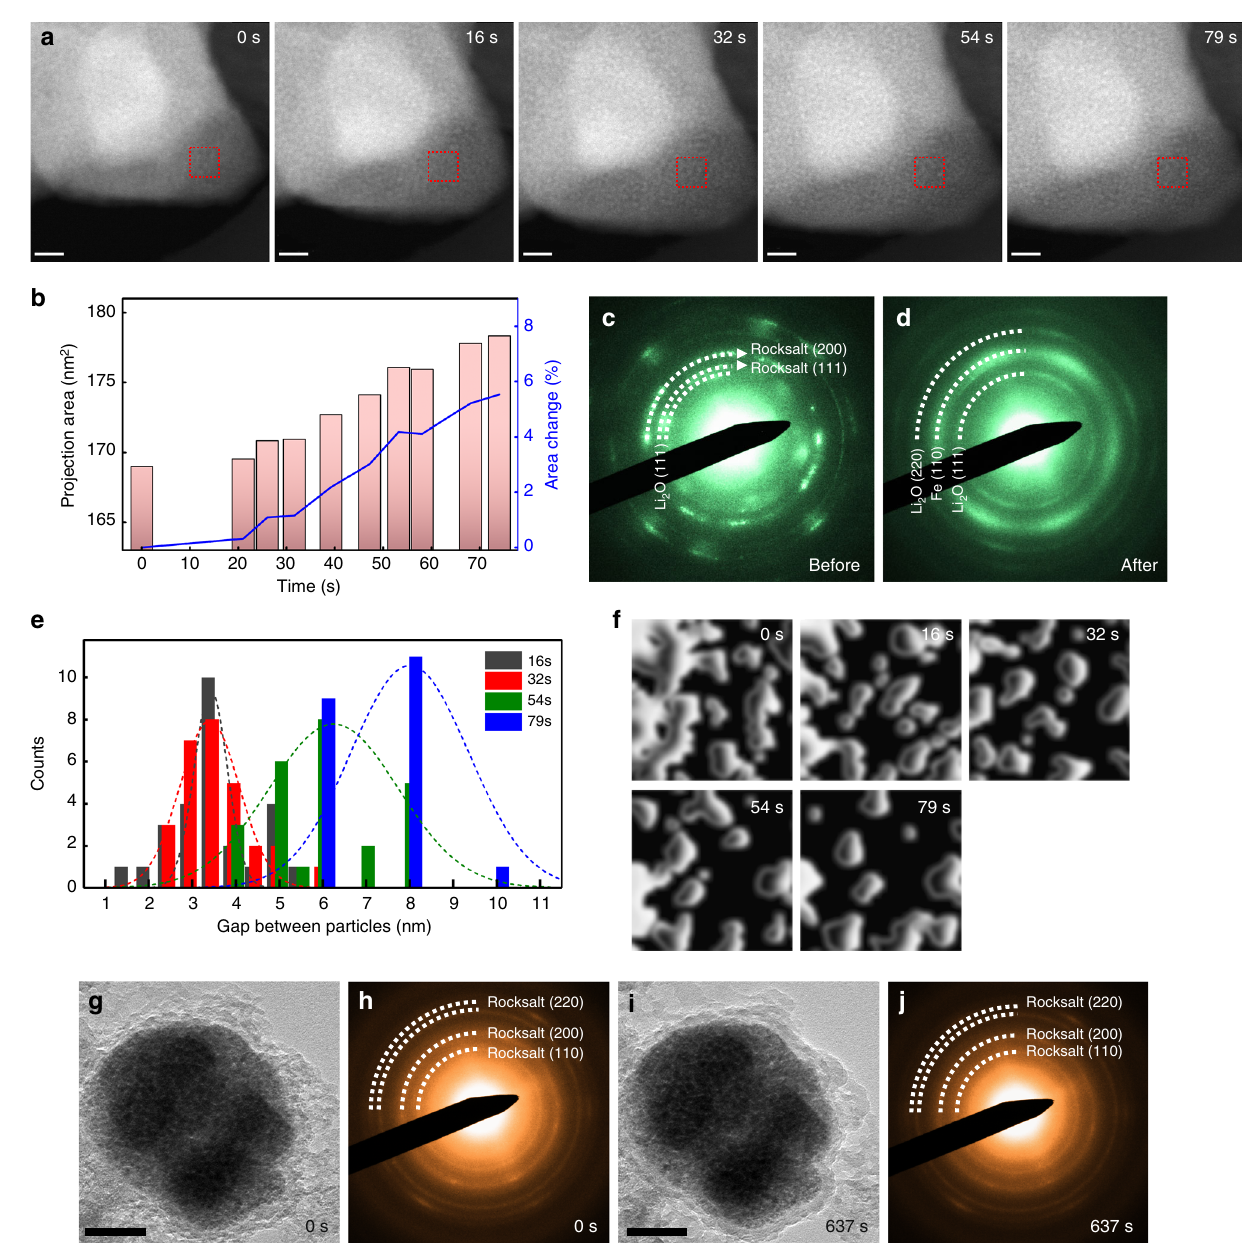
Fig. 4 Real-time observation of lithiation behavior of Fe 3 O 4 -cycled electrode. a Time series of HAADF image showing lithiation reaction of Fe 3 O 4 electrode after three cycles. Scale bar: 20 nm. b Area change of sample shows in a as a function of reaction time. SAED pattern of Fe 3 O 4 — three cycled electrode c before d after in situ lithiation. e The change of the gap between fi ne particles of a upon lithiation. f Particle contour maps of marked areas in a . BF image and corresponding SAED of Fe 3 O 4 − 100-cycled electrode g , h before and i , j after in situ lithiation. Scale bar: 50